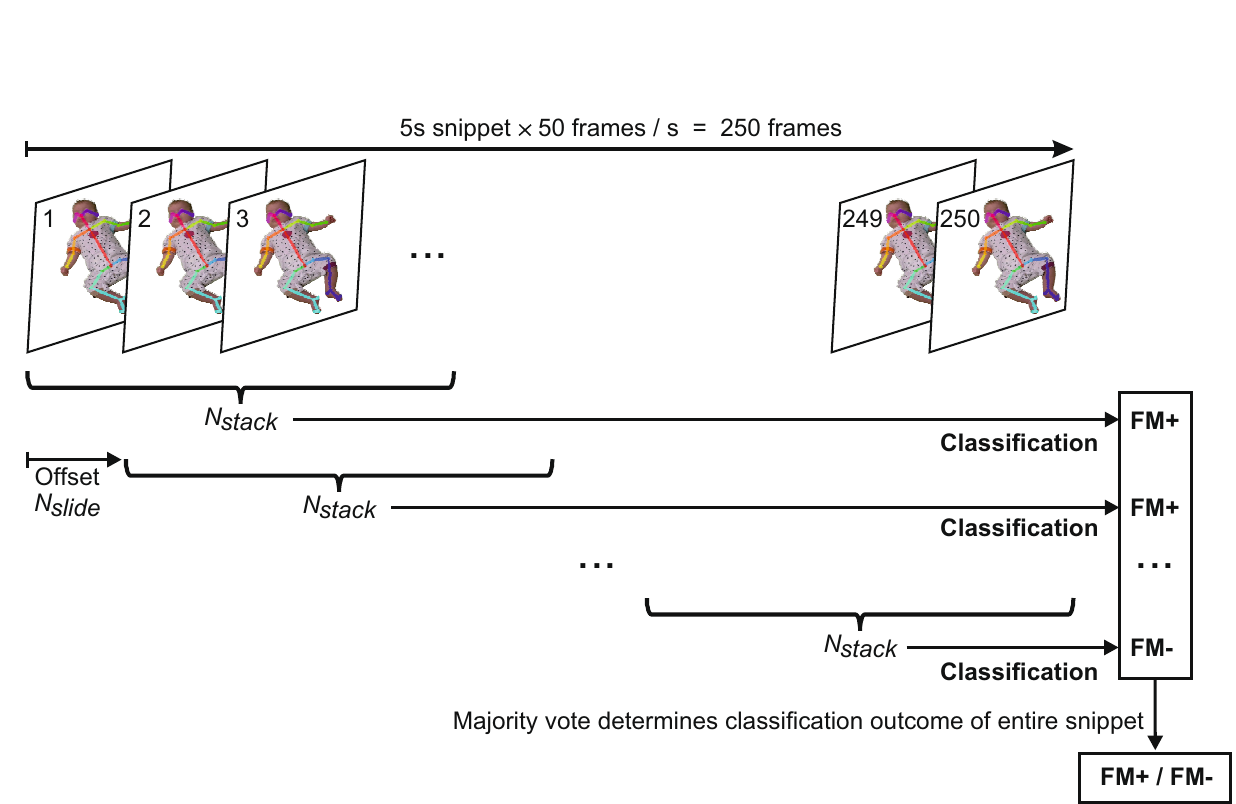
Figure 2. An overview of the feature extraction and classification procedure. One snippet has a length of 250 frames . N = 52 frames are concatenated to one input vector—i.e. the ( x , y )-values of 52 frames frames stack are stacked together to form one input vector. The offset between two input vectors is N slide = 12 frames , resulting in a sliding window approach. Each input vector is classified independently. The final decision is made based on uniform majority